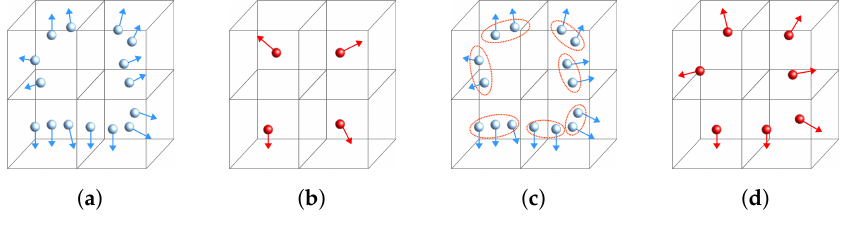
Figure 6. Representation of the normal clustering voxel-grid downsampling. ( a ) original cloud with a voxel-grid structure; ( b ) common downsampling by average; ( c ) novel proposed clustering approach; ( d ) result of the proposed clustering